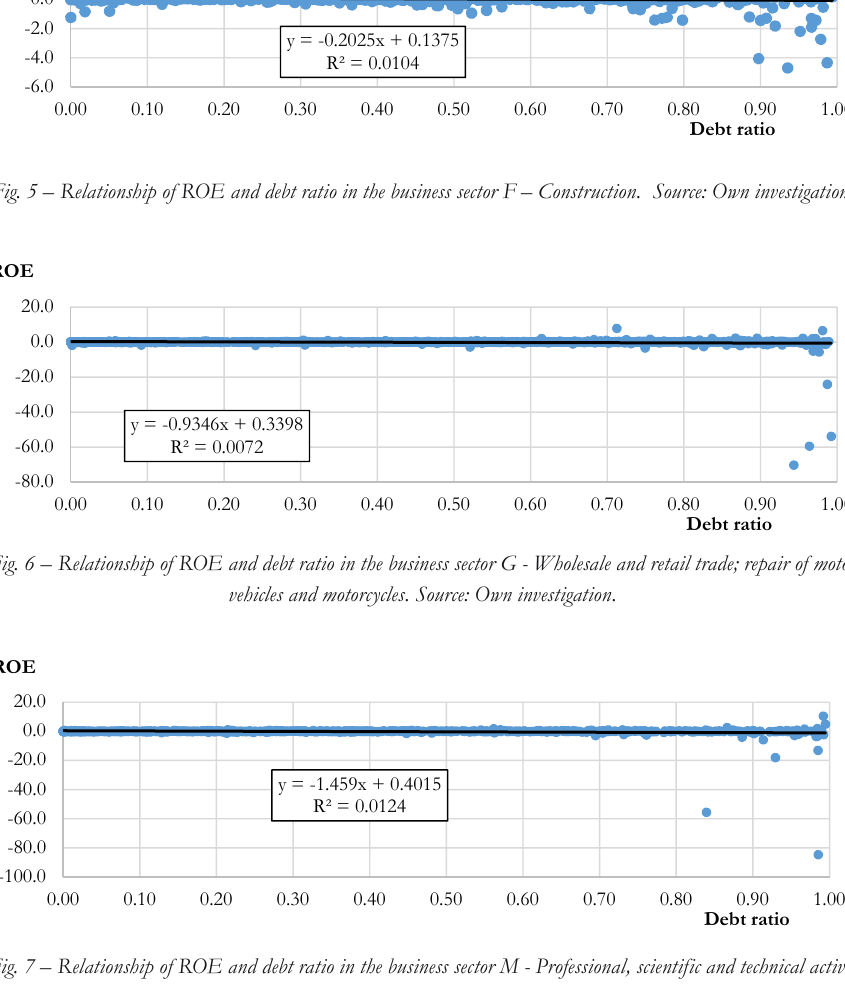
Fig. 7 – Relationship of ROE and debt ratio in the business sector M - Professional, scientific and technical activi- ties. Source: Own